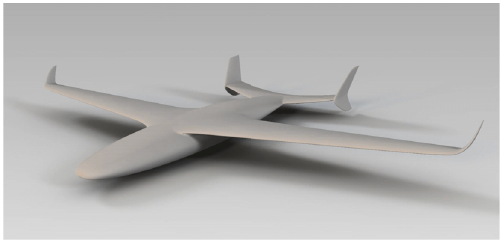
Figure 2: The second concept of the VTOL UAV.